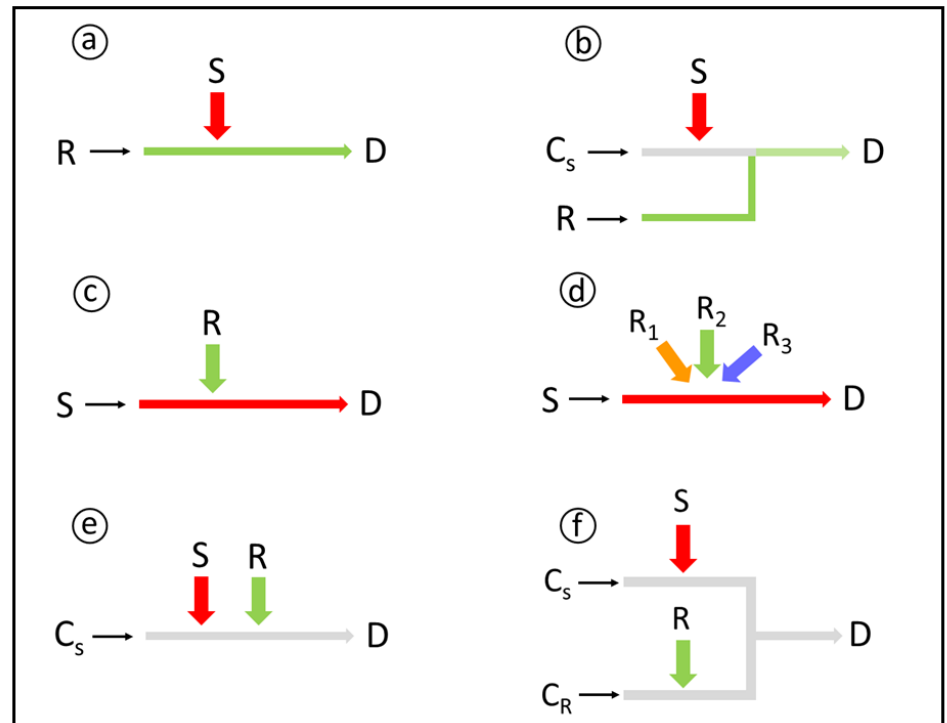
Figure 1. Configurations for sample and reagent insertions in flow analysis. S: sample; R, R 1 , R 2 , R 3 :